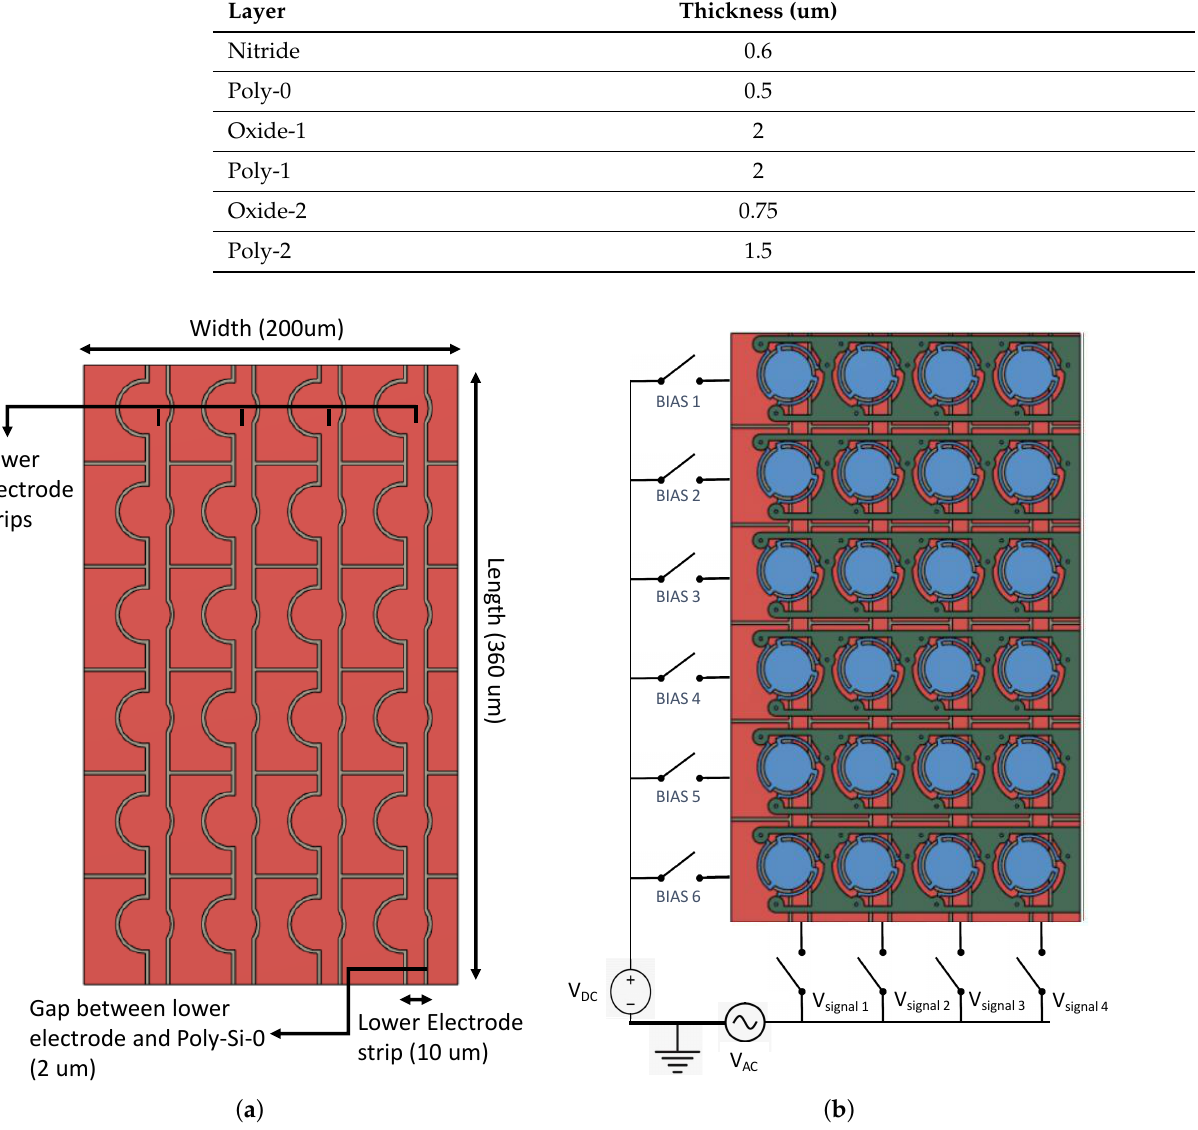
Figure 4. Top View of CMUT array. ( a ) Array dimension; ( b ) full array topology and electrical actuation